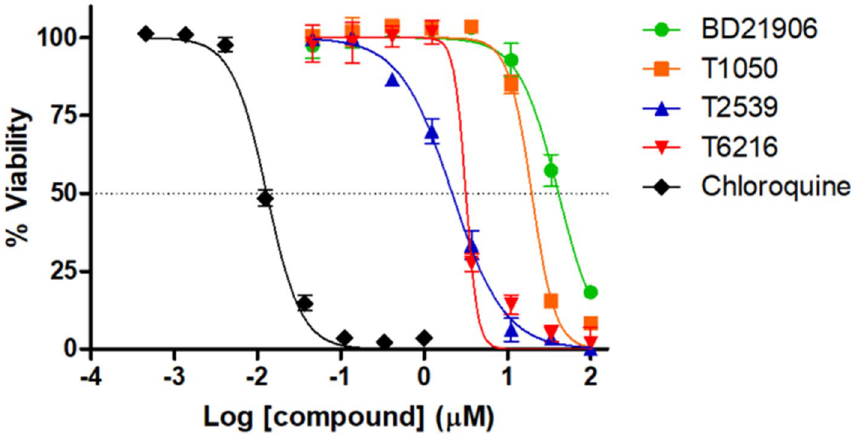
Figure 7. Antiplasmodial dose–response plots. P. falciparum viability percentage was plotted against the Log (compound concentration). The IC 50 (50% inhibitory concentration) was obtained from the curve by non-linear regression. The black curve represents the positive control chloroquine. Compounds were tested in triplicate with the standard deviation (SD) indicated by the error bars. Curves for BD21906, T1050, T2539, T6216 correspond to the following compounds terazosin (DB01162), prazosin (DB00457), fingolimod (DB08868) and abiraterone (DB05812)